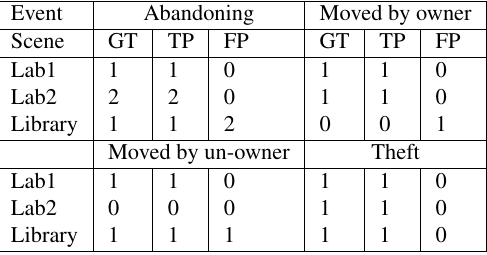
Table 3: Experimental results on our video dataset